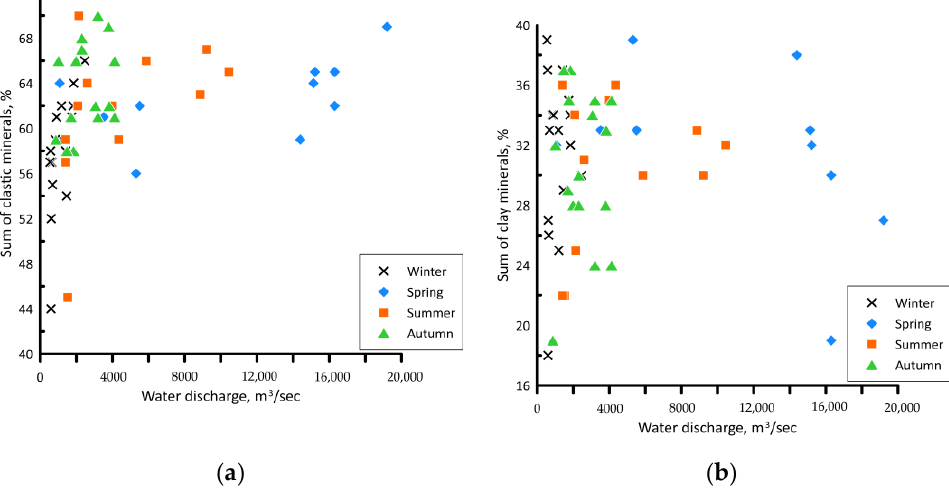
Figure 9. Dependence of the sum of clastic ( a ) and clay ( b ) minerals on the water discharge across the seasons.